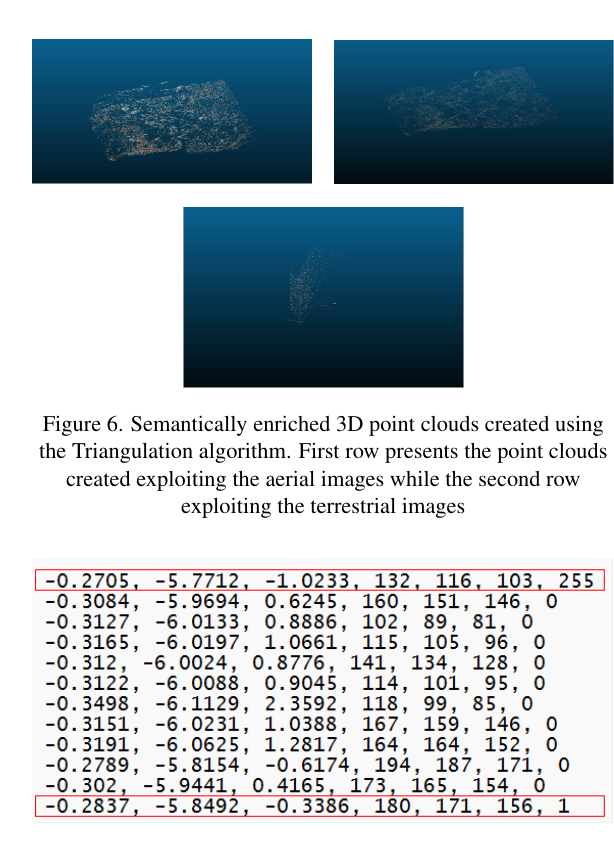
Figure 7. ASCII file produced using the Triangulation algorithm